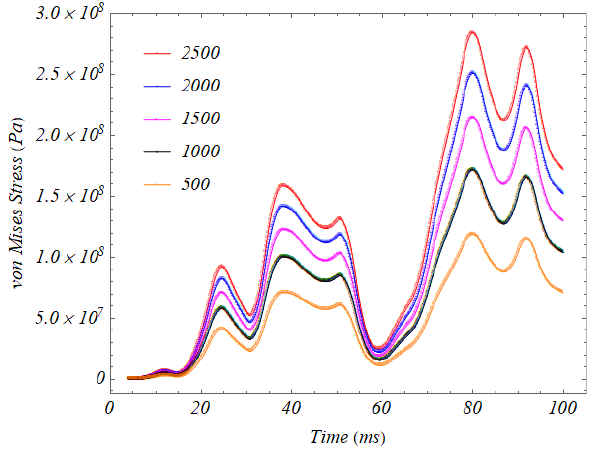
Fig. 23. von Mises stress against time for various drop distances with two cellphone casing